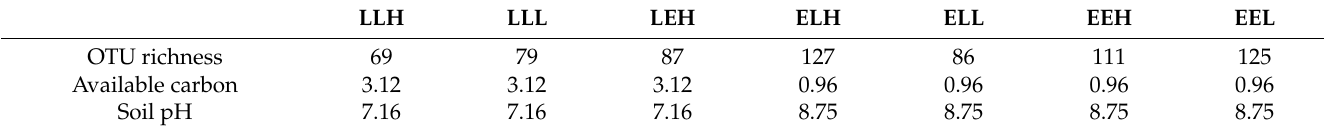
Table 1. Operational taxonomic unit (OTU) richness found in individual soil samples, amount of available carbon in substrate for individual treatments, and soil pH taken from Frouz et al. [38]. LLH LLL LEH ELH ELL EEH OTU